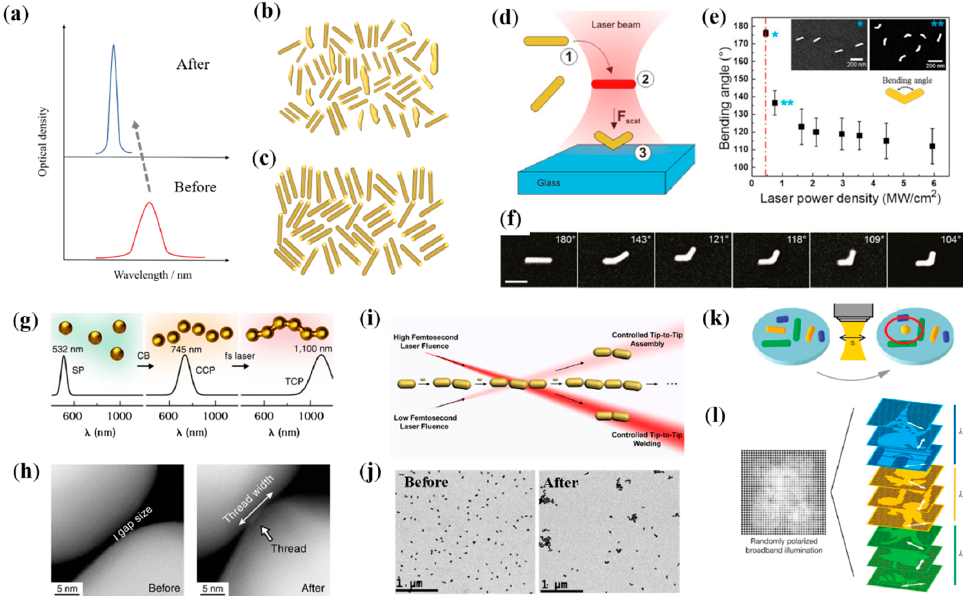
Figure 2. ( a – c ) Reshaping of Au Nanorods with the irradiation of femtosecond laser. ( a ) Schematic illustration of optical density spectra of Au Nanorod colloids before (red) and after (blue) laser irradiation. ( b , c ) Schematic illustration of Au Nanorods morphology before ( b ) and after ( c ) laser irradiation. ( d – f ) Plasmon-assisted bending of Au Nanorods [64]. ( d ) Schematic diagram of optical bending of Au Nanorods. ( e ) Au nanorods transition from a straight (*) to a bent (**) morphology and the control of bending angle with the tune of optical power. ( f ) SEM images of bent Au Nanorods. Scale bar is 100 nm. ( g , h ) Plasmon-assisted processing of Au NPs strings [65]. ( g ) Schematic illustration. ( h ) TEM images Au NP chains before (left) and after laser irradiation (right). ( i , j ) Plasmon-assisted assembling and welding of Au nanorods [66]. ( i ) Schematic illustration. ( j ) TEM images of Au nanorods before and after assembling. ( k , l ) Plasmon-assisted spherification of Au nanorods [67]. ( k ) Schematic illustration of plasmon-assisted spherification of Au nanorods. ( l ) Patterns observed on the detector when irradiated by non-polarized broadband light (left) and light with right polarization and wavelength (right).